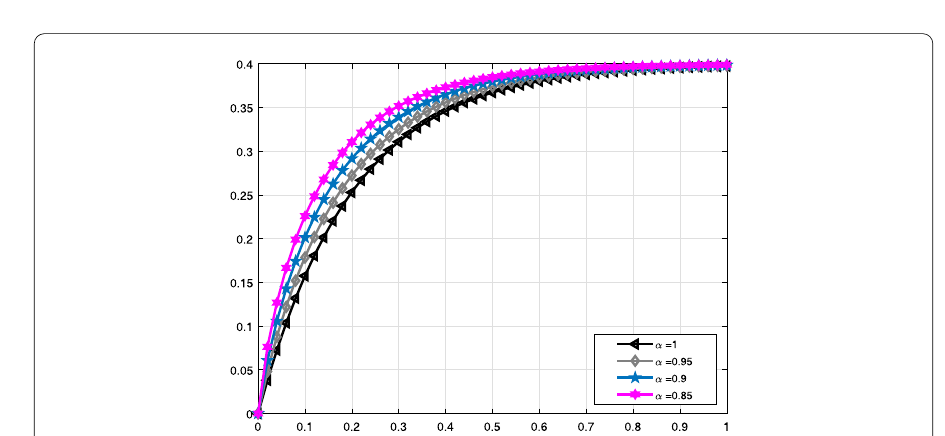
Figure 4 Comparative analysis with conformable derivative for V i ( t )